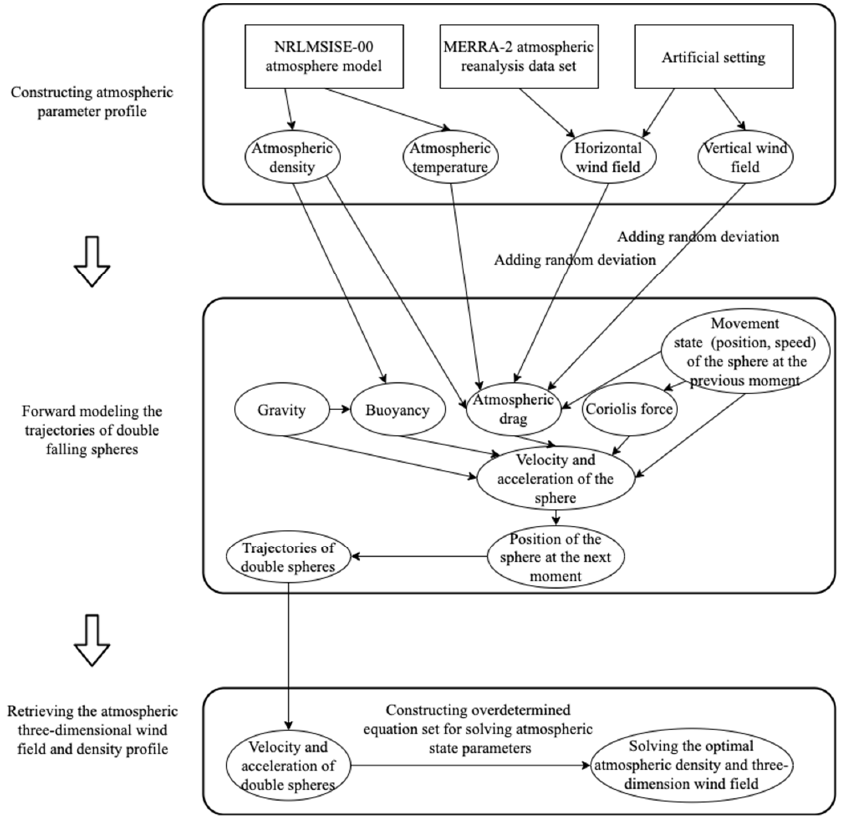
Figure 2. Flow chart of the simulation experiment.